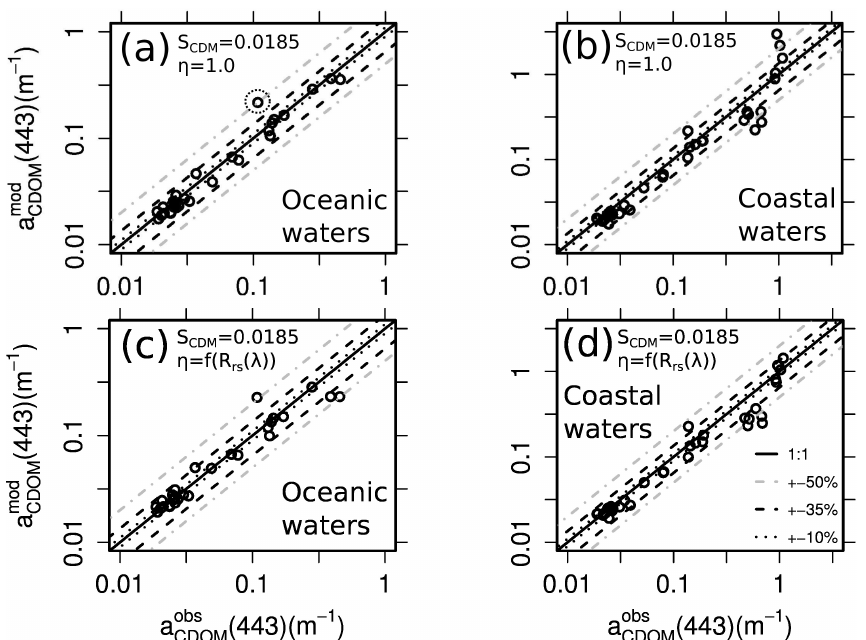
Fig. 4. A comparison of estimated CDOM absorption ( a mod using a fixed η = 1 . 0 and S CDM = 0 . 0185 (case 1-1 in Table 2) for (a) oceanic and (b) coastal waters. Lower panels: a mod as a function of R rs (λ) and a constant S CDM = 0 . 0185 (case 2-1 in Table 2) for (c) oceanic and (d) coastal